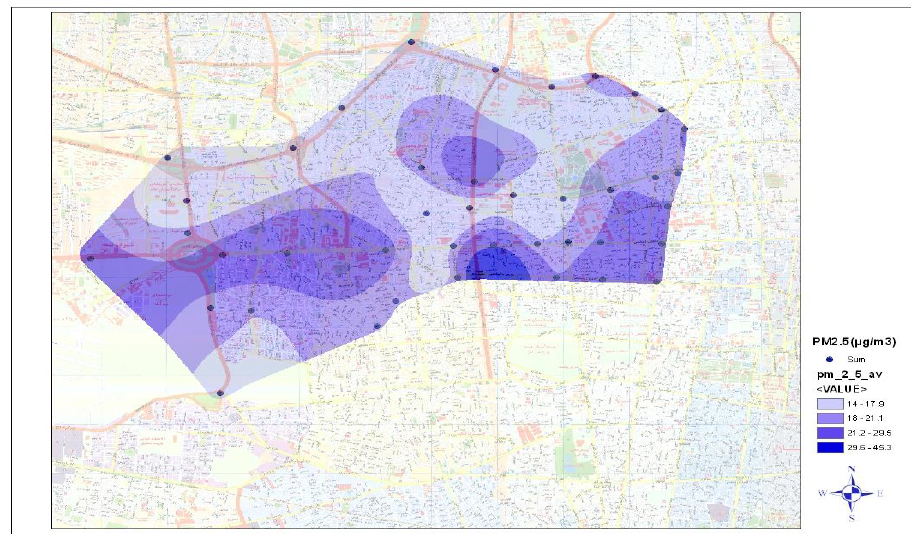
Figure 4. The distribution of mean concentration of PM 2.5 in the selected region (warm season).